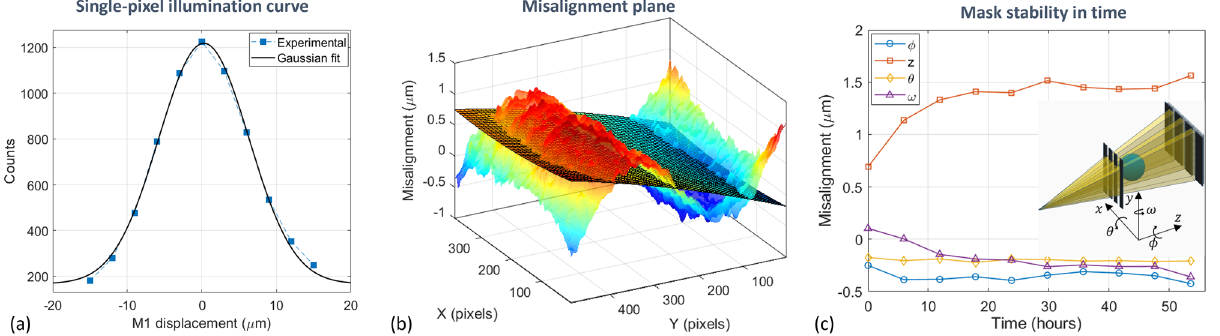
Figure 6. In ( a ) a plot of a single-pixel illumination curve (blue points) and the corresponding Gaussian fit (black line). In ( b ) an example of a misalignment plane (color surface) acquired in double-mask modality, together with the second-order polynomial 2D fit (meshed surface) used to determine positioning misalignment. In ( c ) the positioning misalignment as a function of time where all the components (angles and direction) are shown